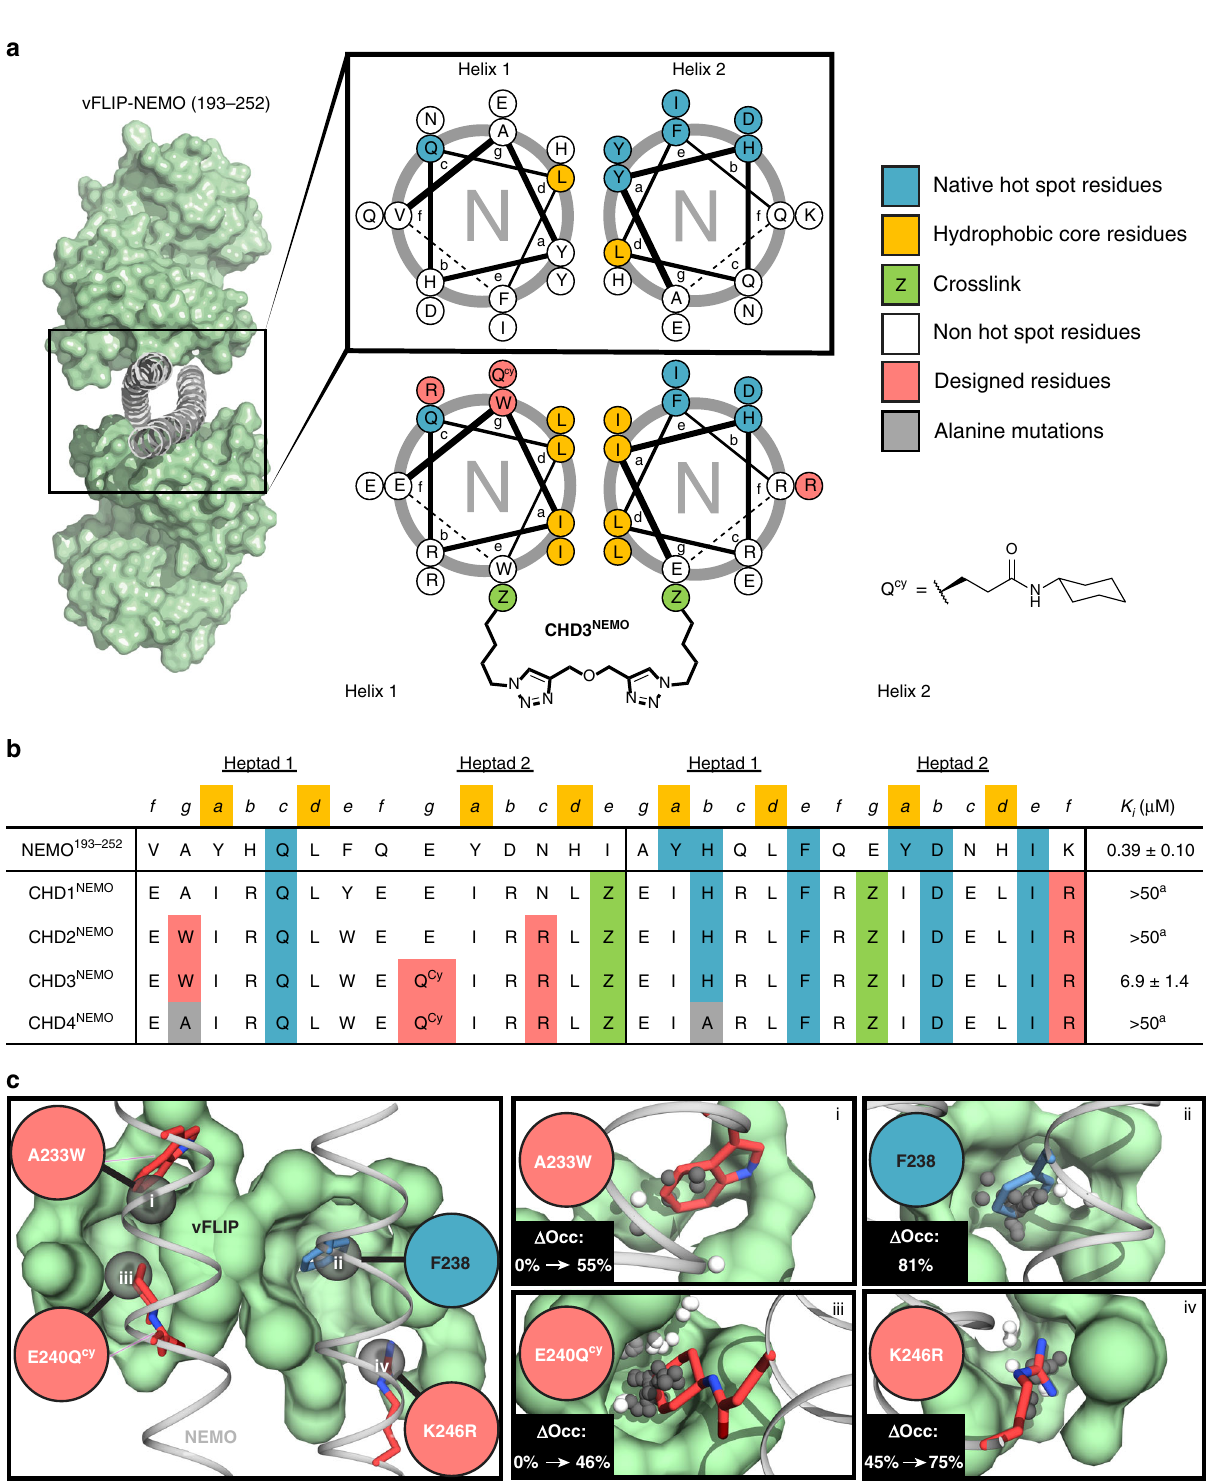
Fig. 2 Rational design of inhibitors of the NEMO-vFLIP interaction. a Helical wheel diagram depicting native (top) NEMO coiled coil and optimized (bottom) sequences. A crosslinker is placed at the e and g positions to constrain the dimer. b Peptide sequences of designed compounds and their respective inhibitory constants from the TR-FRET assay. Superscript ‘ a ’ denotes incomplete dissociation of the NEMO-vFLIP complex observed at 100 μ M concentrations (Fig. 3a). c Cartoon depicts four high-ranking pockets identi fi ed by AlphaSpace and corresponding residues from CHD3 NEMO . The changes in %pocket occupancy as a result of three mutations are